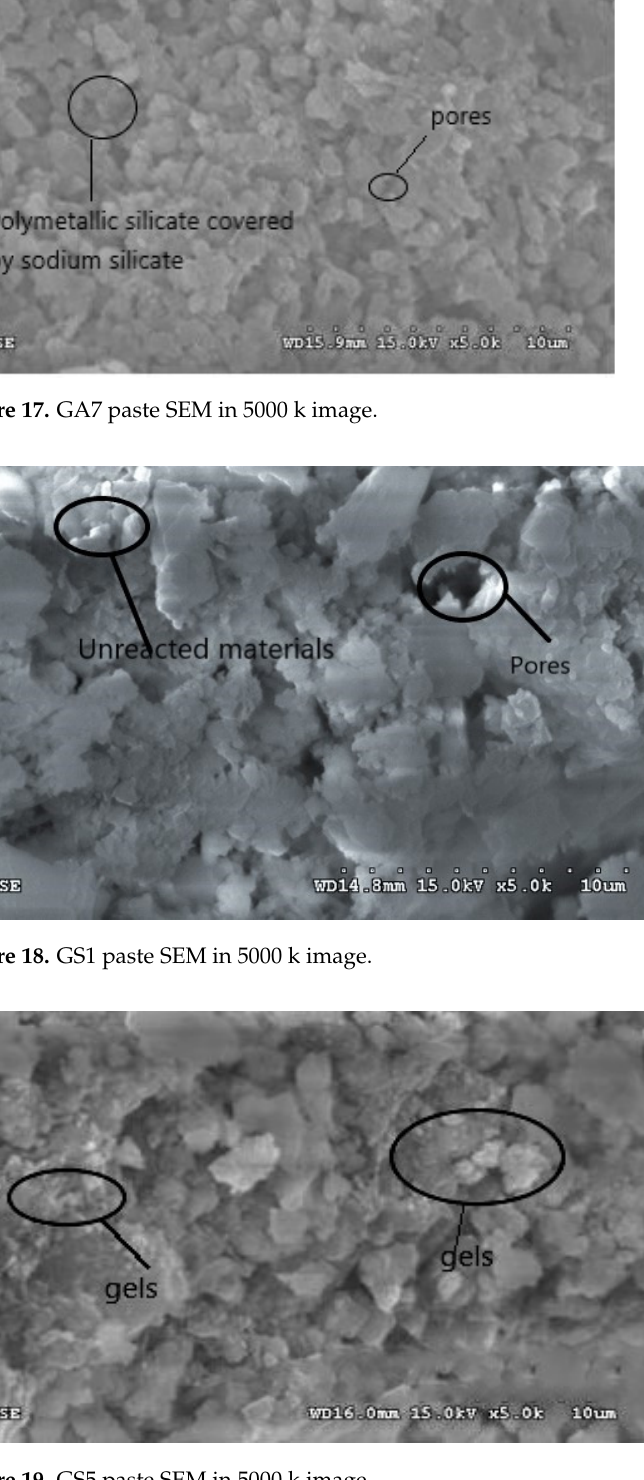
Figure 19. GS5 paste SEM in 5000 k image.